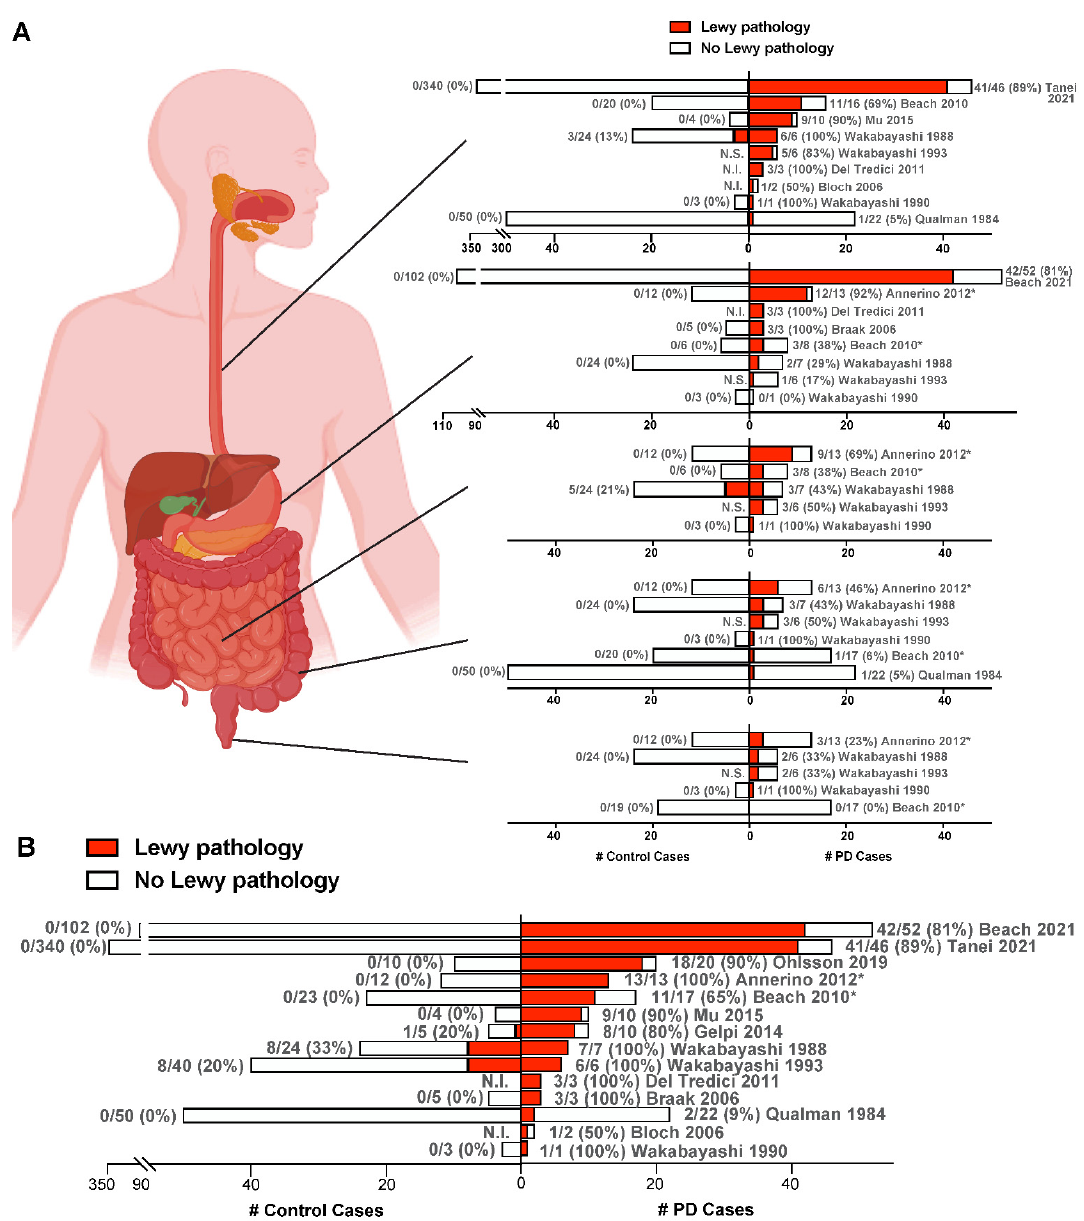
segment of the gastrointestinal tract (165/212; 78%) far exceeds that in controls (17/618; 3%) (Figure 2B). These findings, therefore, support the notion that α -synuclein aggregation in the ENS is a characteristic feature of PD.